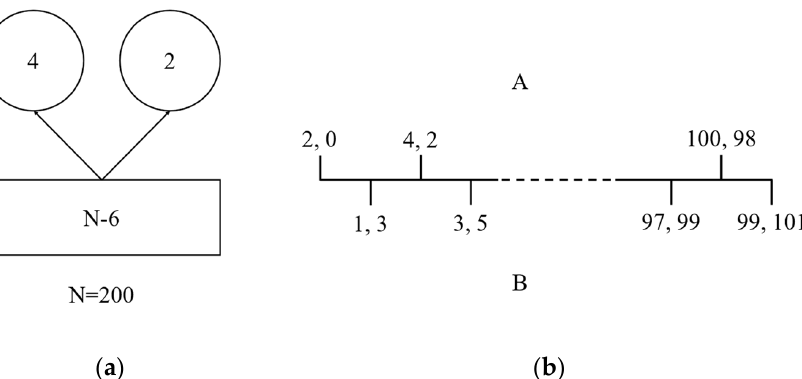
Figure 3. Centipede game model: ( a ) Description of game item: a square box with N − 6 gold coins and two round containers with 4 and 2 gold coins respectively; ( b ) Description of the game process. Before the comma is the return of A, after the comma is the return of B.